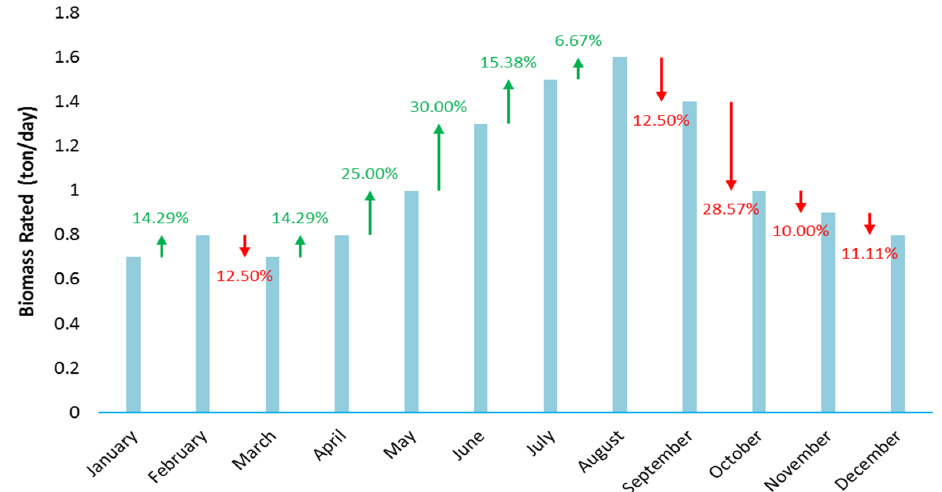
Figure 5. The yearly wind speed of the studied area.